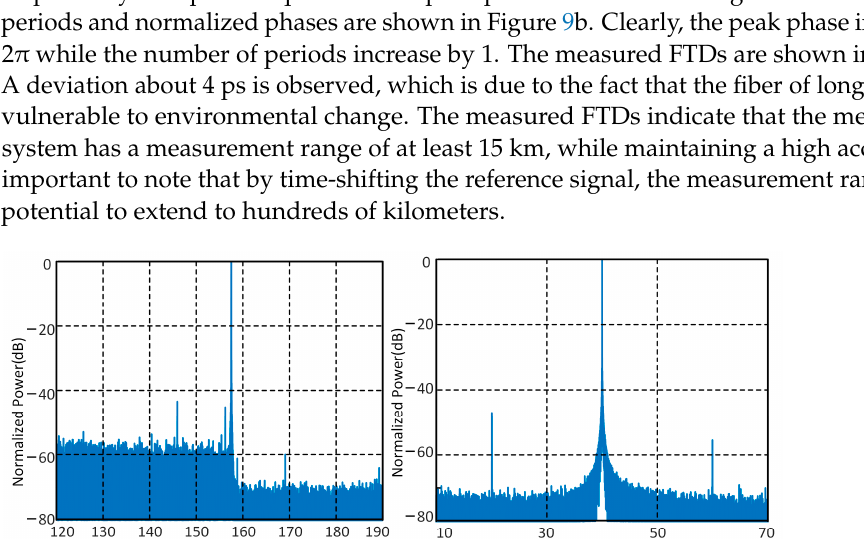
Figure 7. ( a ) The measured FTDs of the variable optical delay line; ( b ) the delay deviations of the measured FTDs.